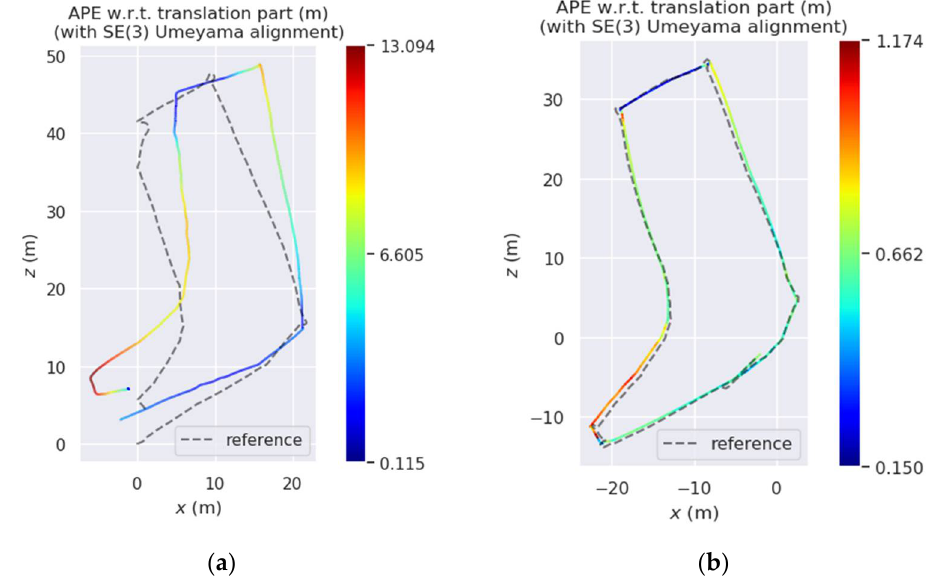
Figure 11. IMU and lidar odometer localization results. ( a ) LiDAR_IMU_calib; ( b ) proposed.